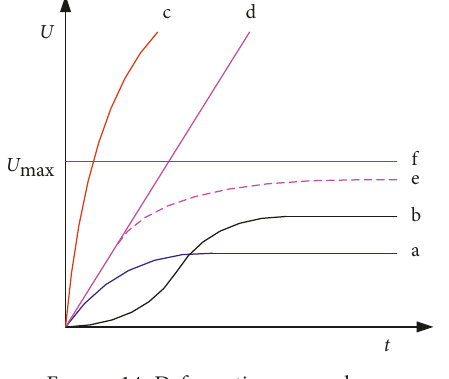
Figure 14: Deformation curve